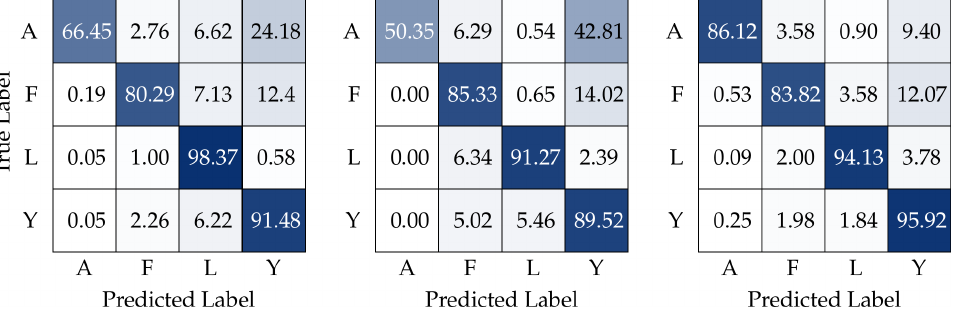
Figure 10. Confusion matrices of results, in percentage (%), obtained by training all three models with the single-user dataset and testing them with the multi-user dataset with different persons not present in the training dataset; the models are SLT ( left ), MSMLT (middle ), and SMLT ( right